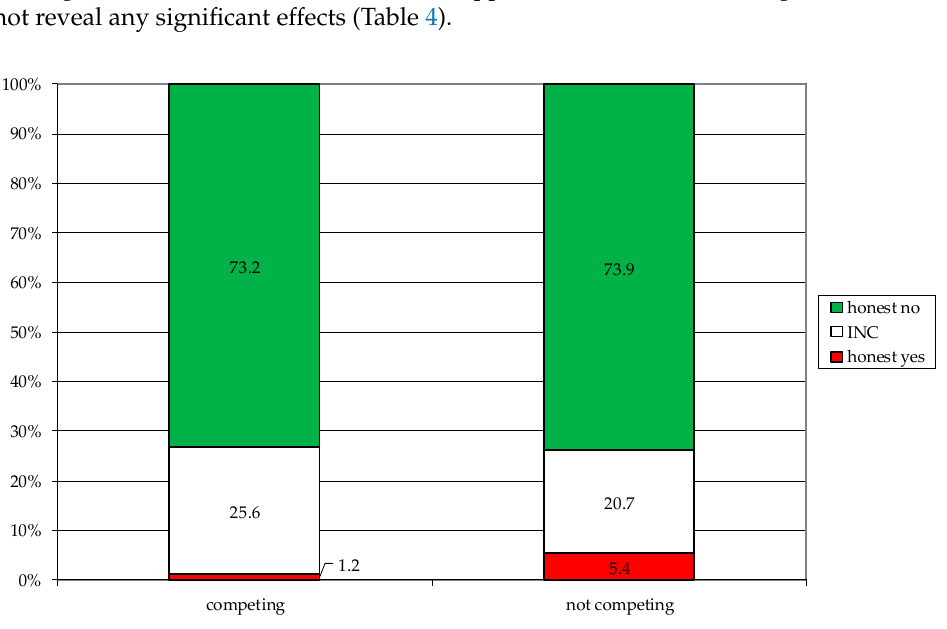
Figure 5. Prevalence of doping among competing and non-competing elite athletes. Table 4. Ex-post test for significance for competing and non-competing